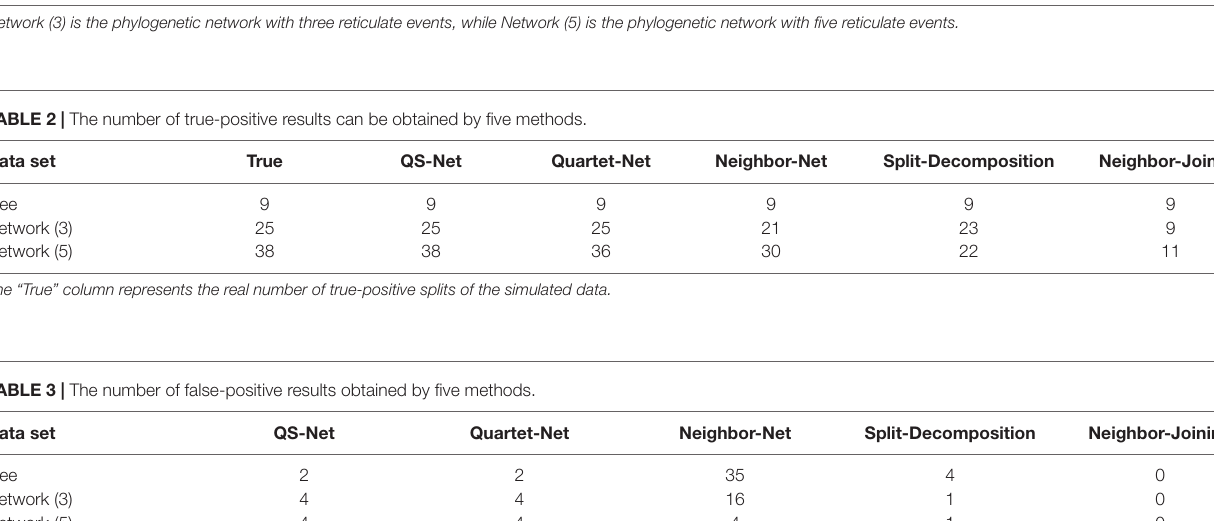
TABLE 2 | The number of true-positive results can be obtained by five methods.